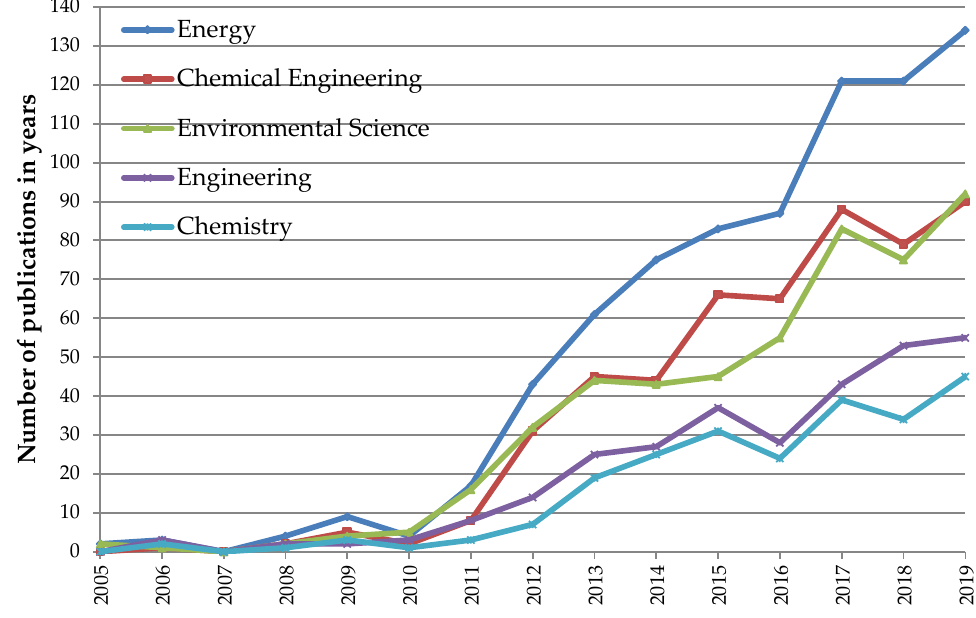
Figure 7. Number of articles in years indexed in Scopus in relation to the Subject